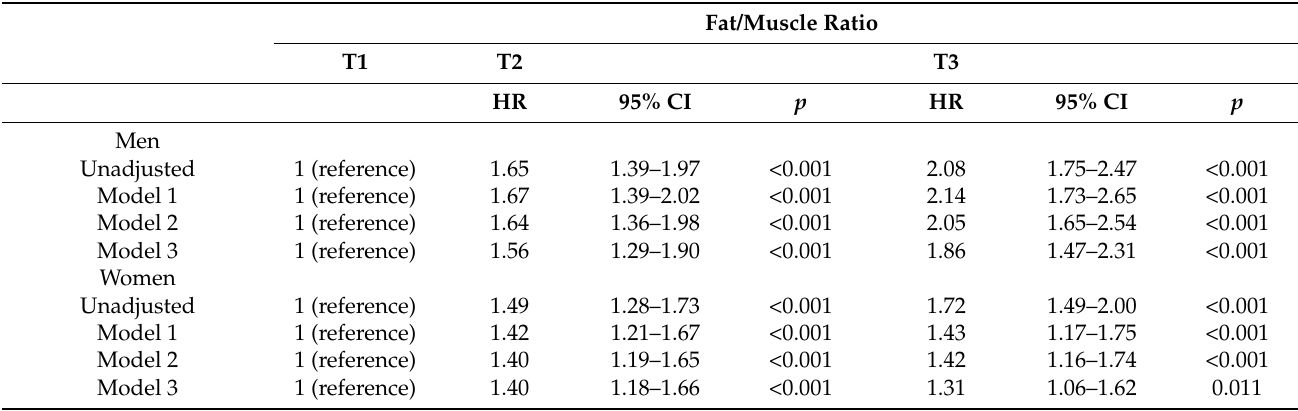
Table 2. HR with 95% CI for the incident non-achievement of LDL cholesterol targets according to the sex-specific tertiles of fat-to-muscle ratio.